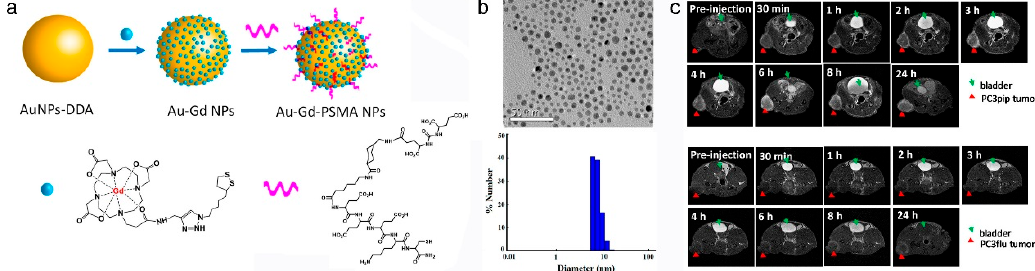
Figure 4. Au-Gd 3+ -prostate-specific membrane antigen (PSMA) NPs for MR-guided radiation therapy. ( a ) Schematic representation of Au-Gd 3+ -PSMA NPs. ( b ) TEM micrograph indicates that the average core size of Au-Gd 3+ -PSMA NPs is 5 nm, and DLS shows that the hydrodynamic diameter of Au-Gd 3+ -PSMA NPs is 7.8 nm. ( c ) In vivo tumor targeting of Au-Gd 3+ -PSMA NPs and MR imaging of PC3pip tumor-bearing mouse (up) and PC3flu tumor-bearing mouse (bottom) obtained at 7 T. PC3pip tumor cell expresses high level of PSMA, while PC3flu tumor cell expresses low level of PSMA (the mice were injected with Au-Gd 3 + -PSMA NPs at 60 µ mol Gd 3 + · kg − 1 through the tail vein, adapted from Basilion et al. 2020 [50], Copyright 2020 The American Chemical Society and reproduced with permission).